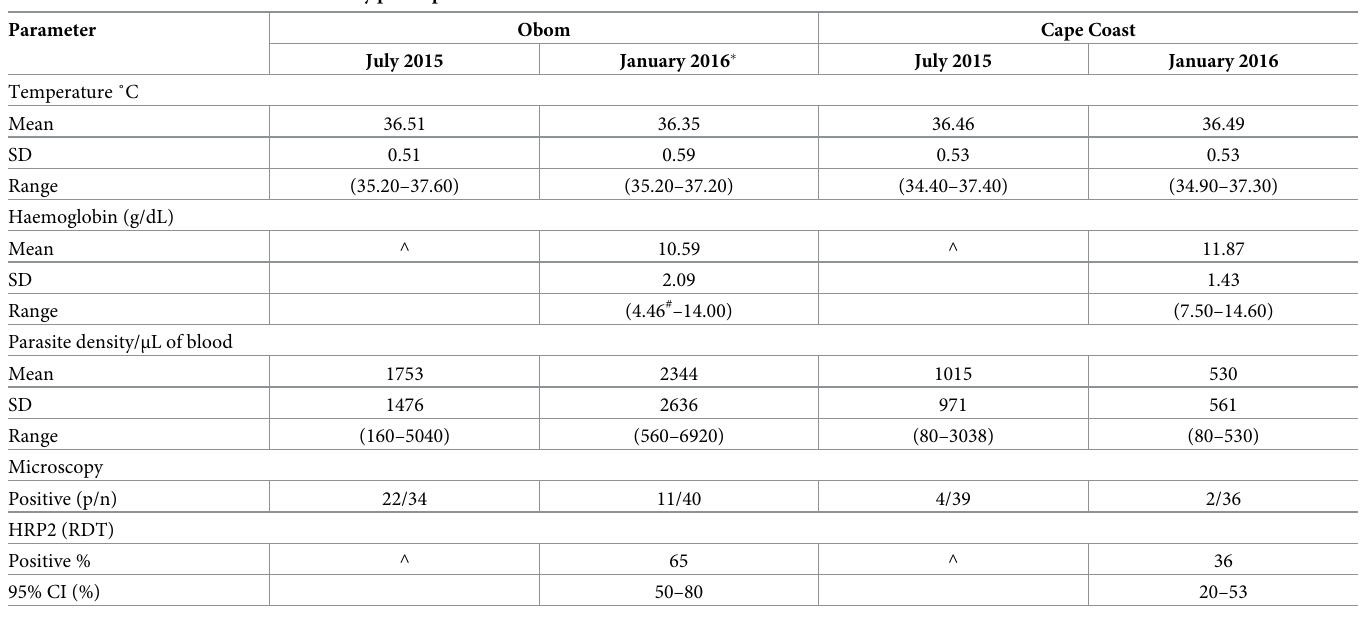
Table 1. Clinical characteristics of the study